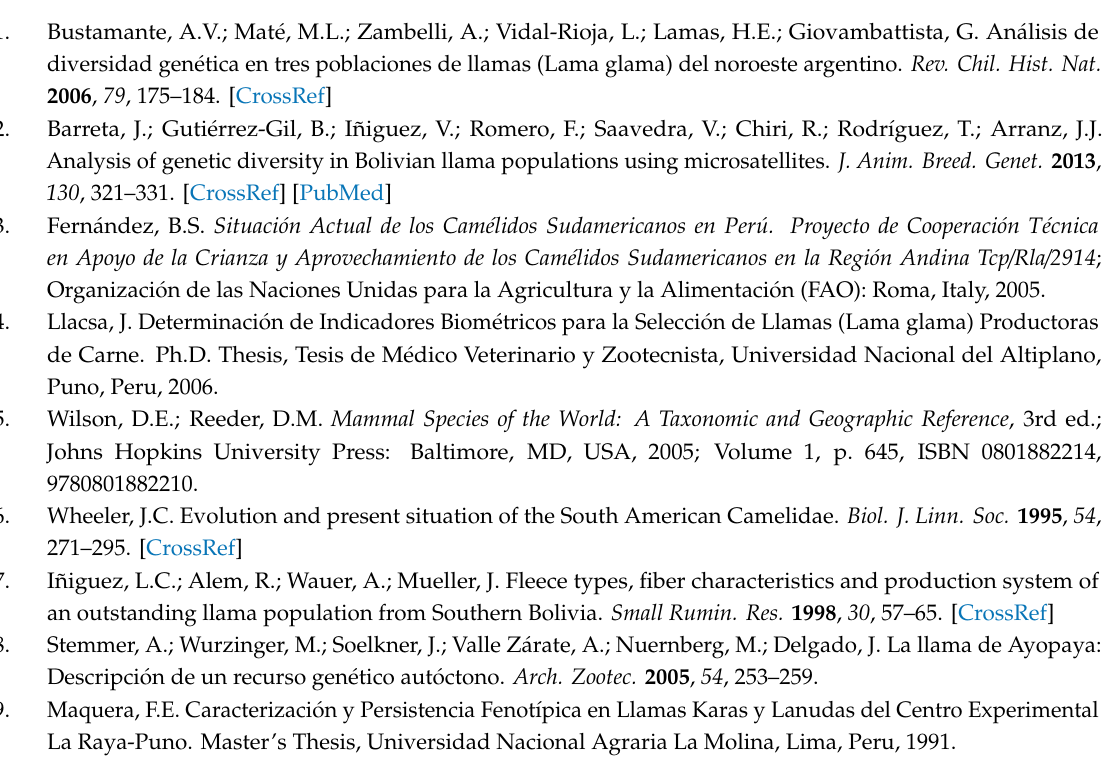
Table S1: Primer sets used for genotyping the microsatellites, Table S2: Existence and Frequencies of null alleles found in each microsatellite marker analyzed with the software Micro Checker 2.2.3 and CERVUS 3.0.3, respectively Table S3: Analysis of molecular variance (AMOVA) between the subpopulations of llamas Ch’aku and